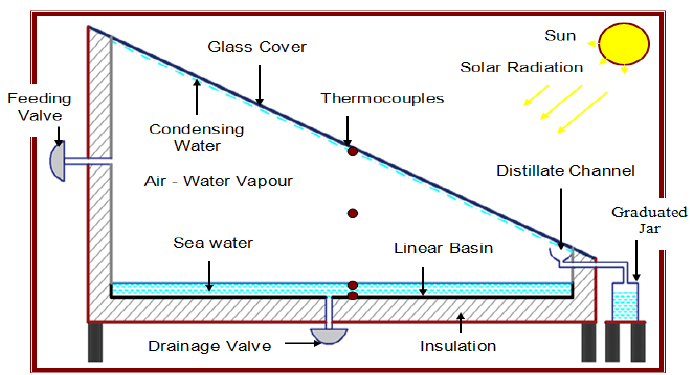
Figure 1. Illustrative section of the single-slope solar still.